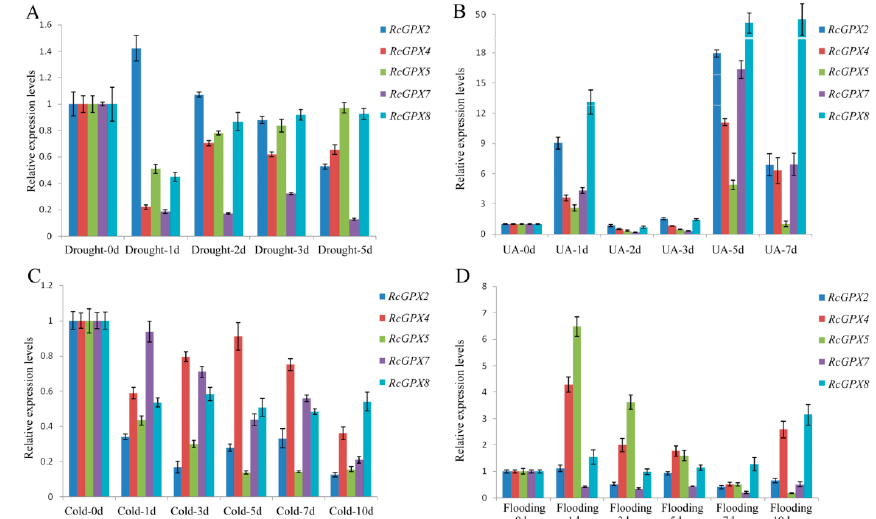
Figure 5. Expression patterns of Rhodiola crenulata glutathione peroxidase ( RcGPXs ) genes for leaves under abiotic stresses. ( A ) Drought stress was used by PEG-4000 (20%); ( B ) UA stress was used the